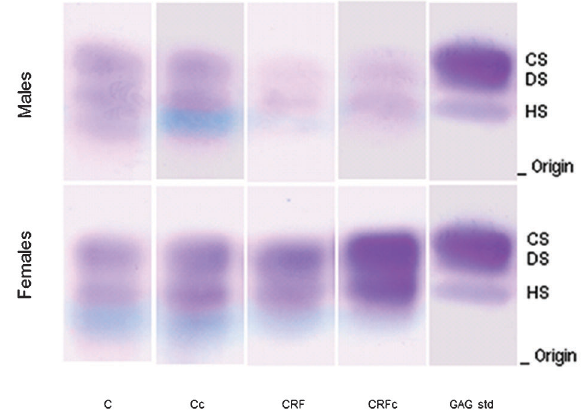
Figure 6. Agarose gel electrophoresis of pooled total excreted glycosaminoglycans (GAGs) in 24-h urine after toluidine blue and Stains-All stainings. CS: chondroitin sulfate; DS: dermatan sulfate; HS: heparan sulfate; C: control; c: castration; CRF: chronic renal failure; F: female rat; M: male rat; GAGs std: mixture of standard